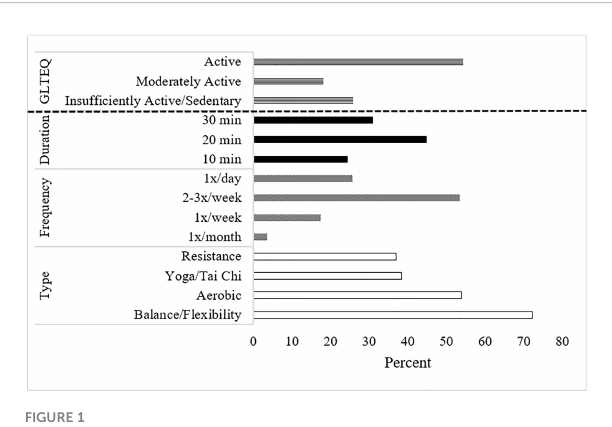
FIGURE 1 Current physical activity behavior and preferences for a future physical activity program.